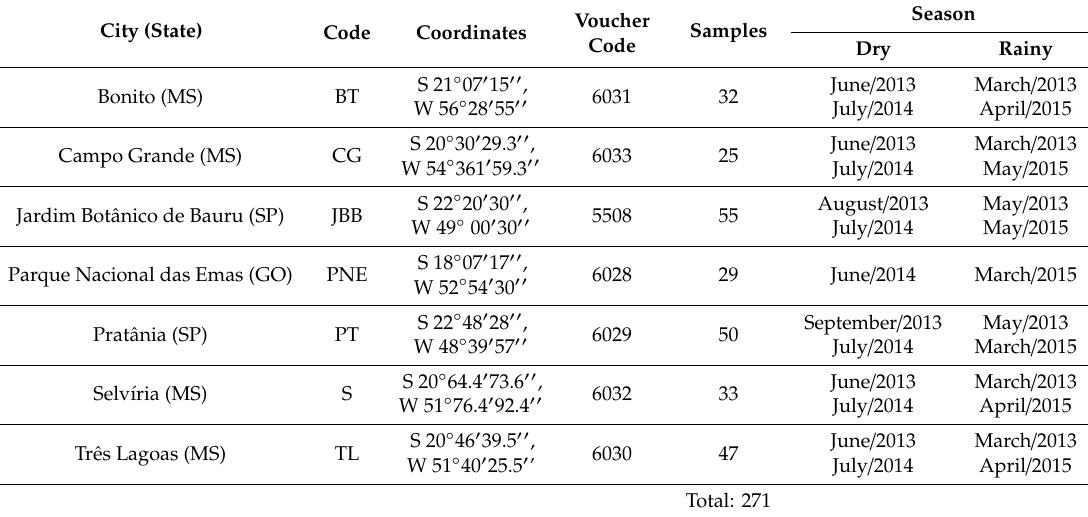
Table 1. Sampling plan of Myrcia bella specimens compared in this study. City and exact coordinates for each sampled area of Cerrado are presented. Samples were collected twice per season, the months and years of each harvest period are given. Only samples from Parque Nacional das Emas-Goi á s were collected once in each season. The total number of samples collected in each area in both seasons is given. A representative specimen voucher for each population was deposited at the UNBA